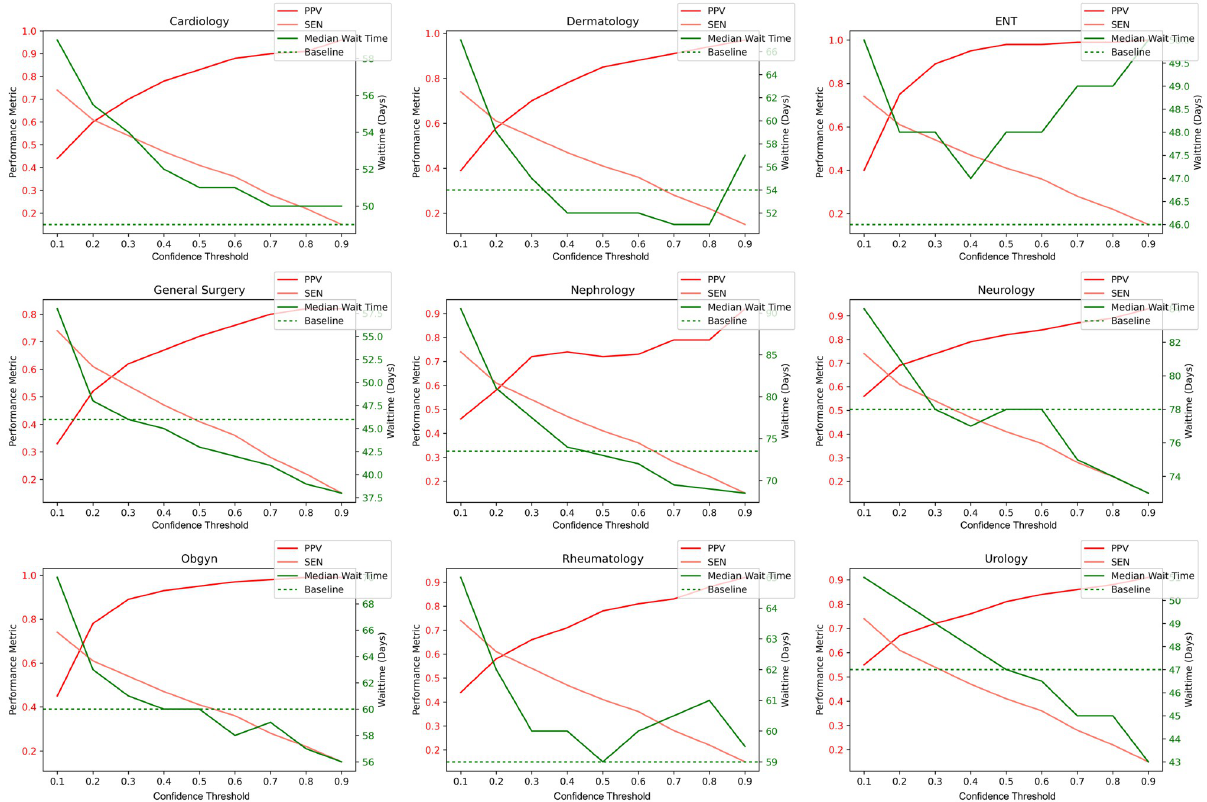
Fig 6. The effect of different confidence thresholds (x-axis) on classification metrics (left y-axis) and estimated median wait times (right y-axis) for the 9 selected specialties. The dashed green line represents the “baseline” wait-time: the wait time if we only estimated using our gold labels (i.e., using patients who only ever had a single referral and specialist consultation in